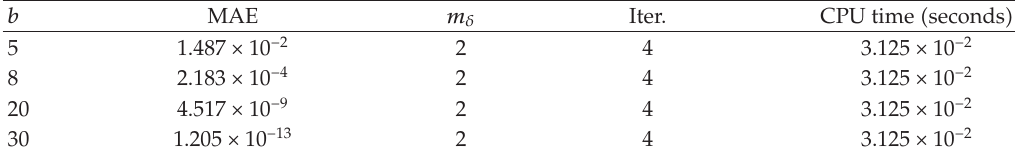
Table 13: Example